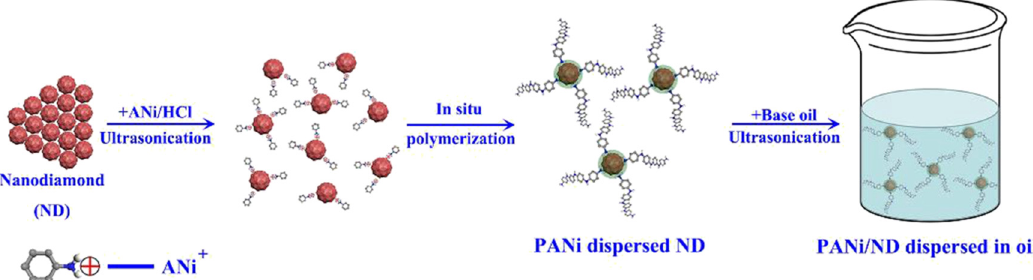
Figure 1: Molecular model of ND dispersed in base